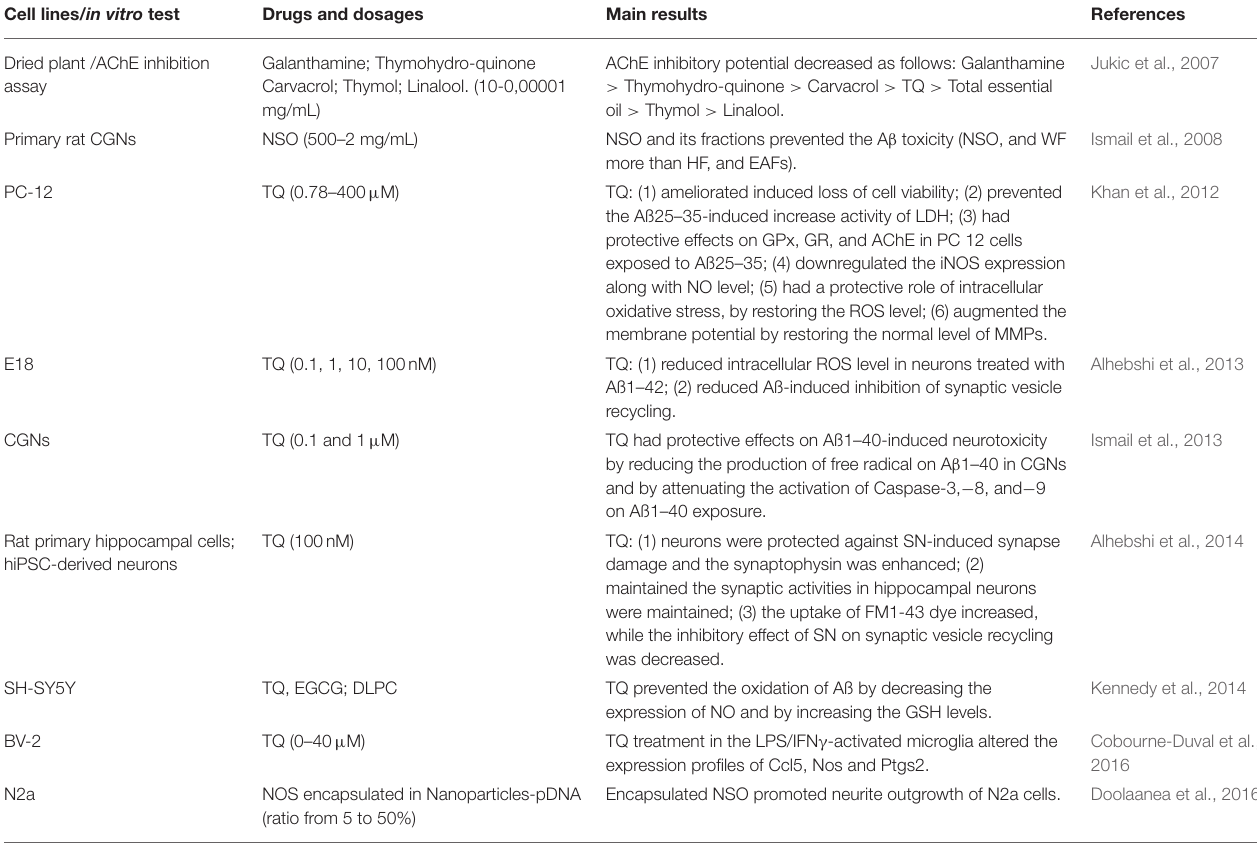
TABLE 1 | In vitro studies on the effects of NS or TQ in